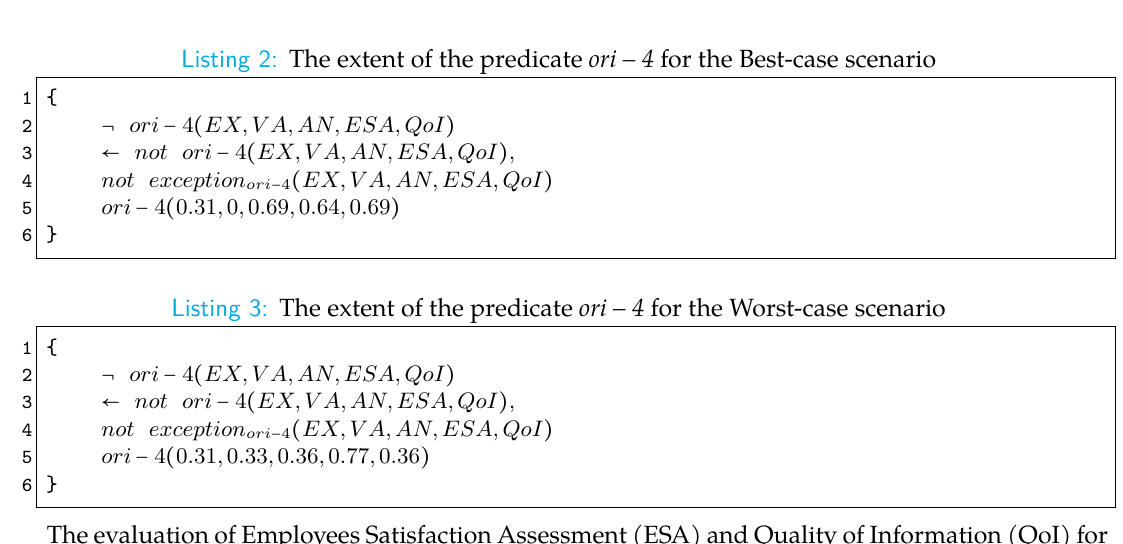
Figure 3: A global view of the energy an employee predicts that has been used by the system to be in the entropic state his/her answer suggests in answering ORI – 4 for Best (a) and Worst (b) case scenarios, per energy type. The dark areas stand for exergy, gray areas denote vagueness and dashed areas represent